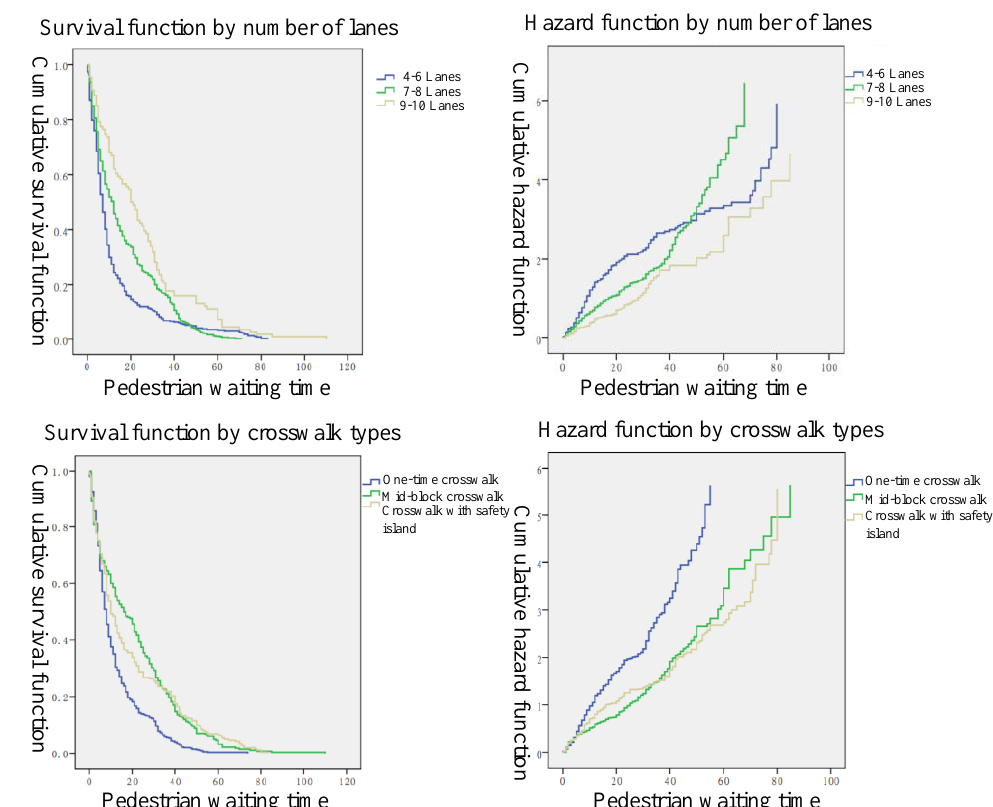
Figure 6. The survival and hazard function curves by different numbers of lanes and crosswalk types.